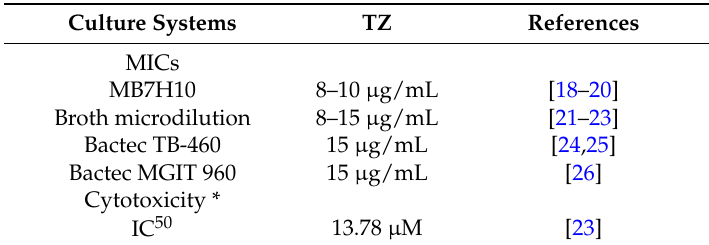
Table 1. Minimum inhibitory concentrations of thioridazine for M. tuberculosis H37Rv reference strain according to the